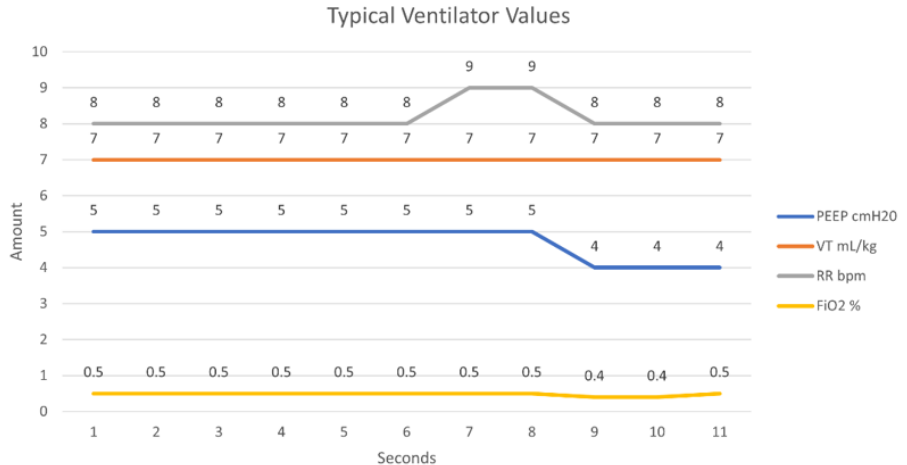
Figure 13. Simulated ventilator parameters under the normal scenario.